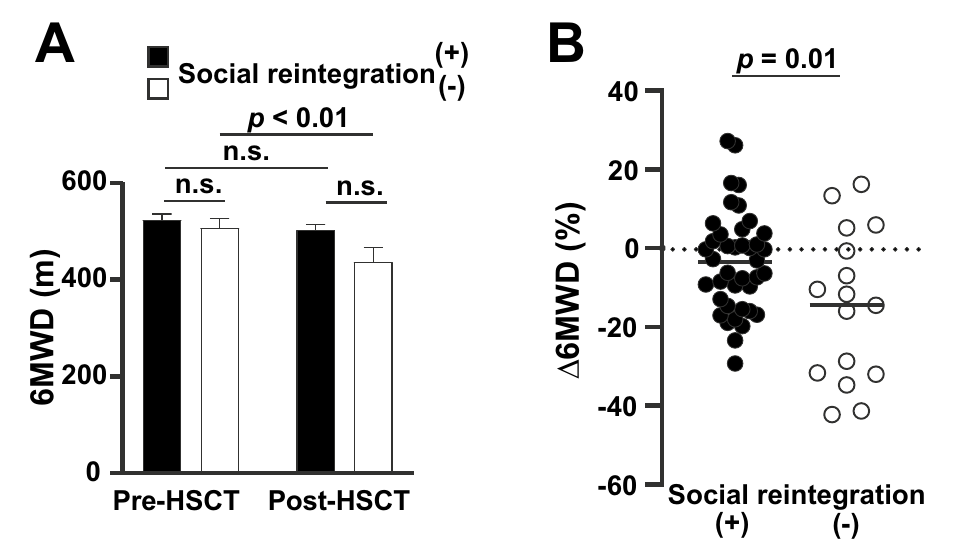
Figure 4. The change of the 6-min walking distance (6MWD) and the correlation with social reintegration. ( A ) Measured 6MWD values (mean ± standard deviation) are shown based on the later social reintegration status at each time-point of pre- and post-HSCT. ( B ) 6MWD changes (Δ6MWD) are plotted